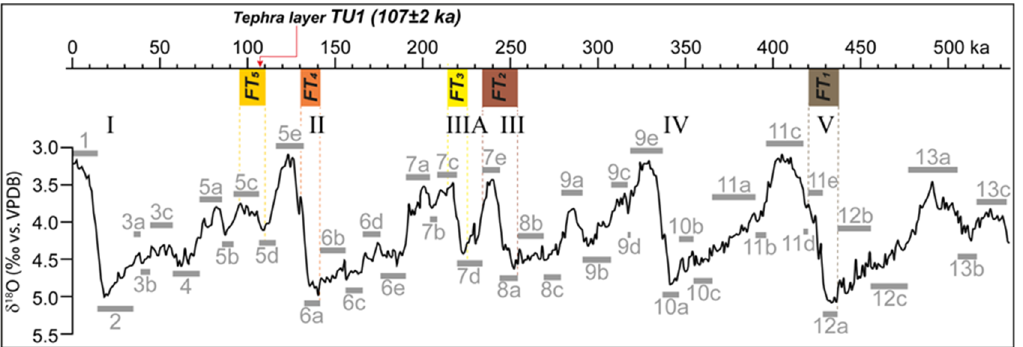
Figure 14. Diagram of the Marine Isotope Oxygen Stages for the last 500 ka (modified after [82]) showing the proposed age of formation of the studied fluvial terraces based on correlations with marine terraces. Red line indicates the chronological position of the TU1 tephra layer in the FT 5 terraced unit.